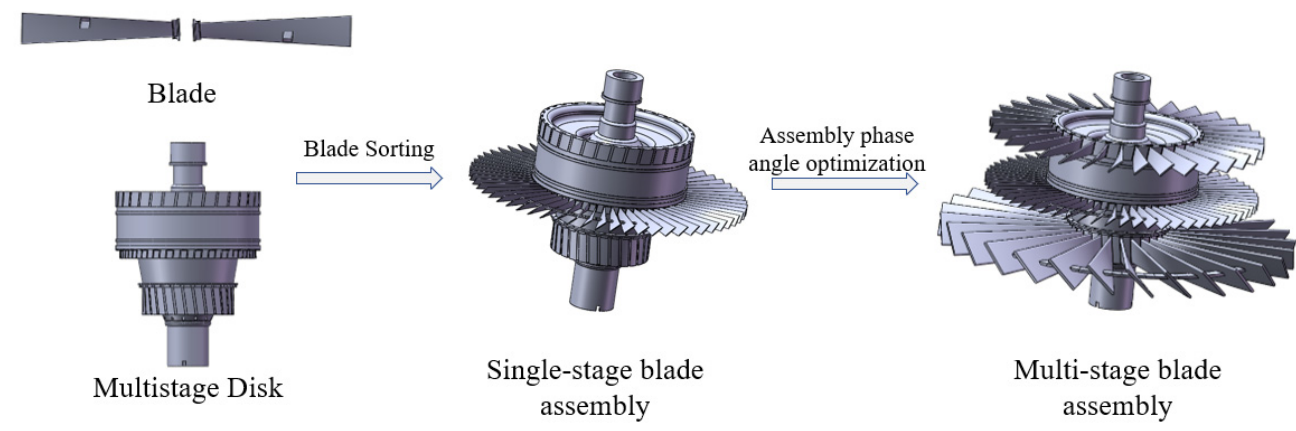
Figure 1. Fan rotor blade assembly process.